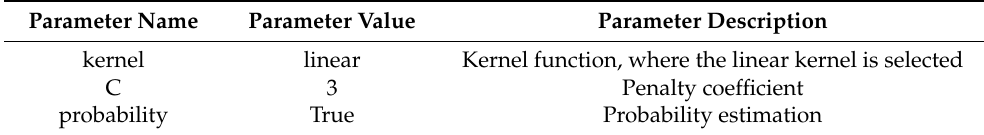
Table 2. Training parameters of the SVM model.